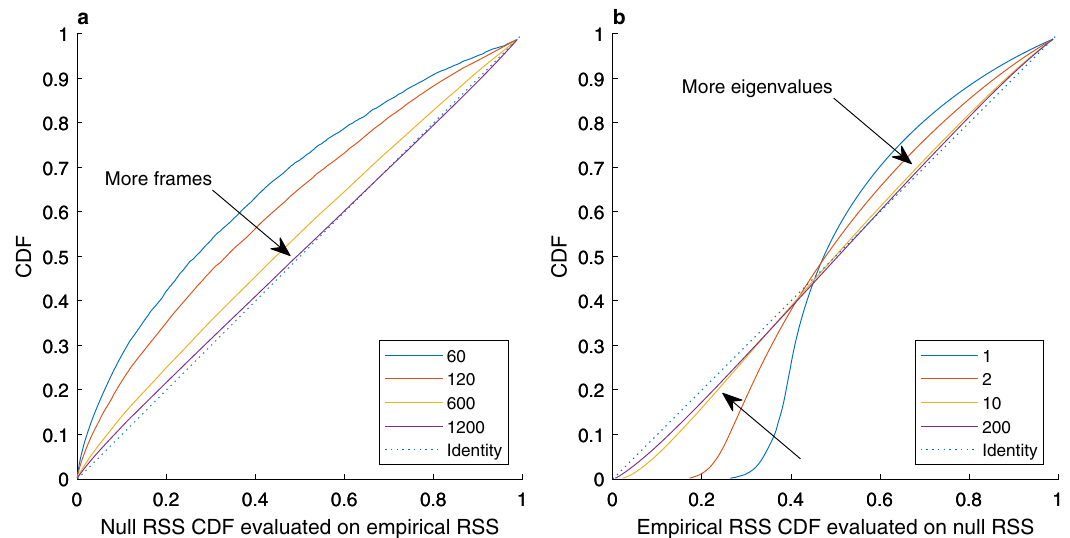
Fig. 4 Properties and convergence of the RSS distribution derived analytically under the static null hypothesis. a The empirical RSS distribution increasingly approximates the null RSS distribution as more realisations (frames) are observed. On the horizontal axis, the cumulative distribution function (CDF) of the null RSS is evaluated for each empirical RSS observation; the CDF of the resulting distribution is plotted on the vertical axis. Identical distributions would produce points on the diagonal (dotted line). b The nFC eigenvalues shape the null RSS distribution. The null RSS distribution increasingly approximates the empirical RSS distribution as more eigenvalues are considered, with the largest eigenvalues explaining most of the variance. On the horizontal axis, the cumulative distribution function (CDF) of the empirical RSS is evaluated for each null RSS observation; the CDF of the resulting distribution is then plotted on the vertical axis. Identical distributions would produce points on the diagonal (dotted line).